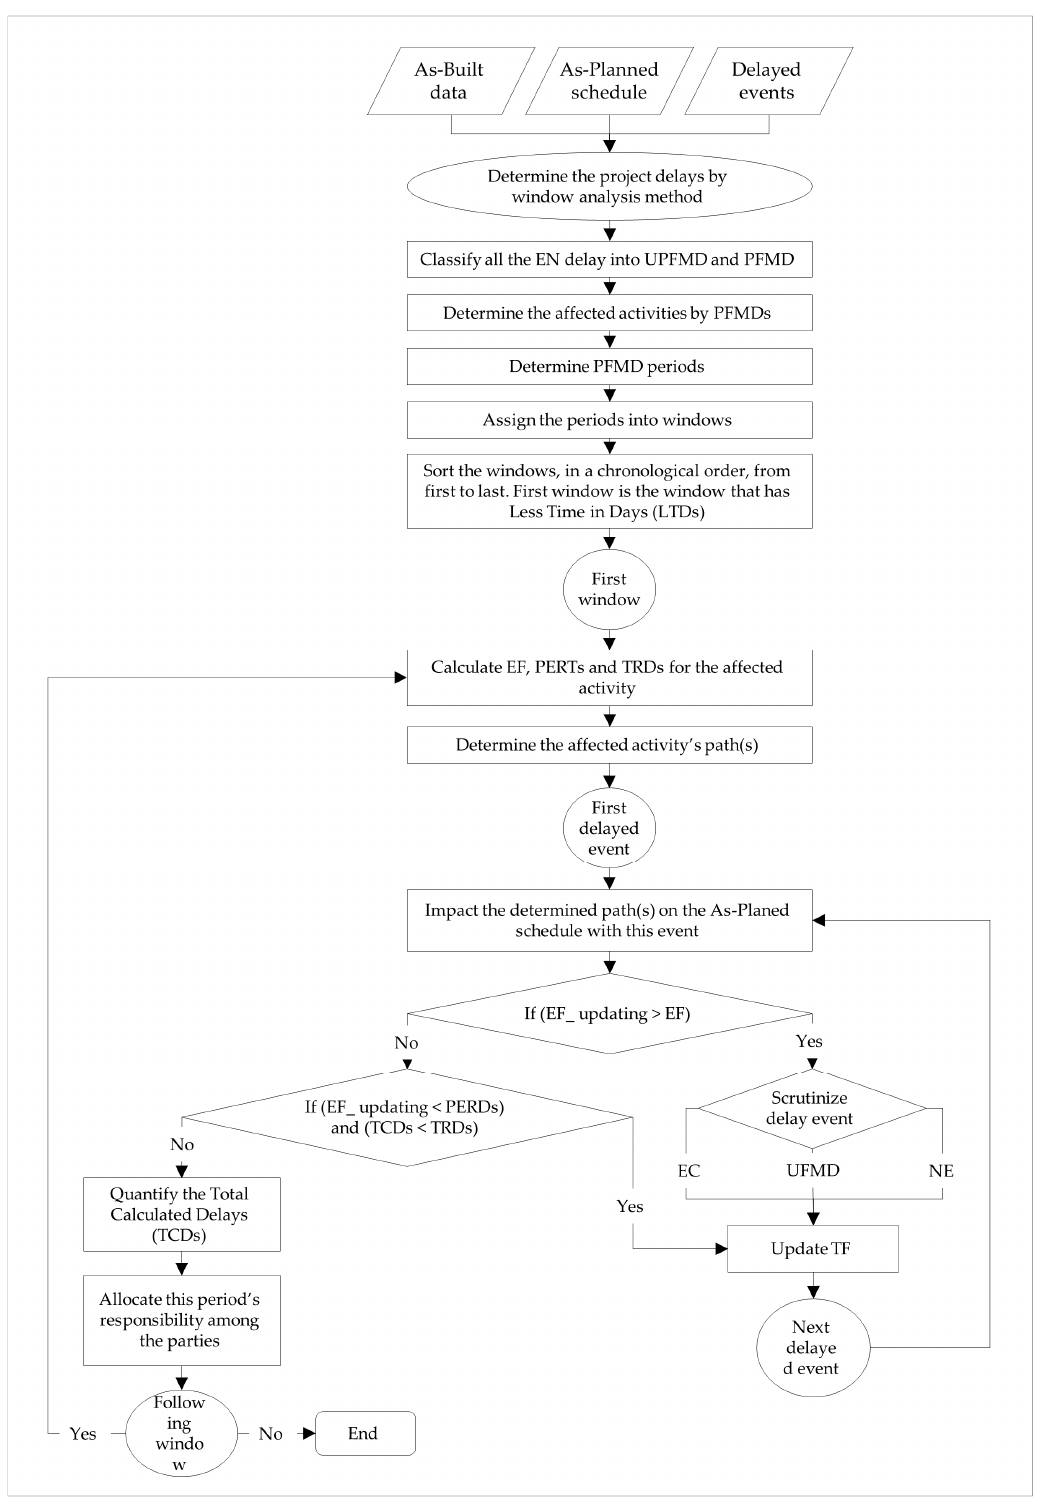
Figure 2. The flowchart of the proposed method.